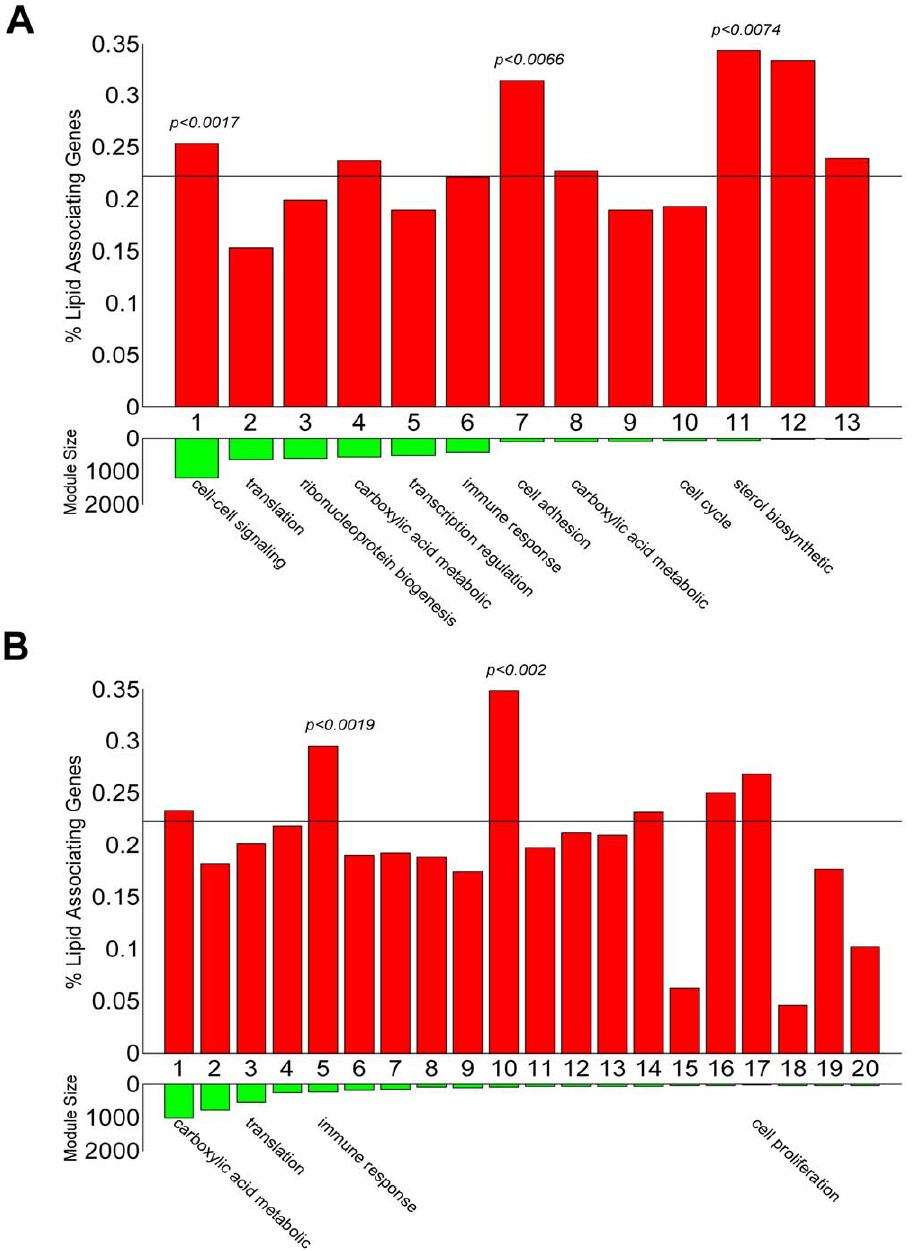
Figure 4. Conserved co-expression modules show better association with human lipid traits. Red bars show the percent of lipid associating genes in each module; the green bars show the module sizes. The dotted horizontal line indicates the background percentage of lipid associating genes. For modules with significantly enriched GO categories, the most representative category is labeled below the green bars. P -values above the red bars are the FET p -value for modules significantly enriched in lipid-associating genes. (A) Conserved co-expression modules. (B) Modules built from the human gene expression data alone.